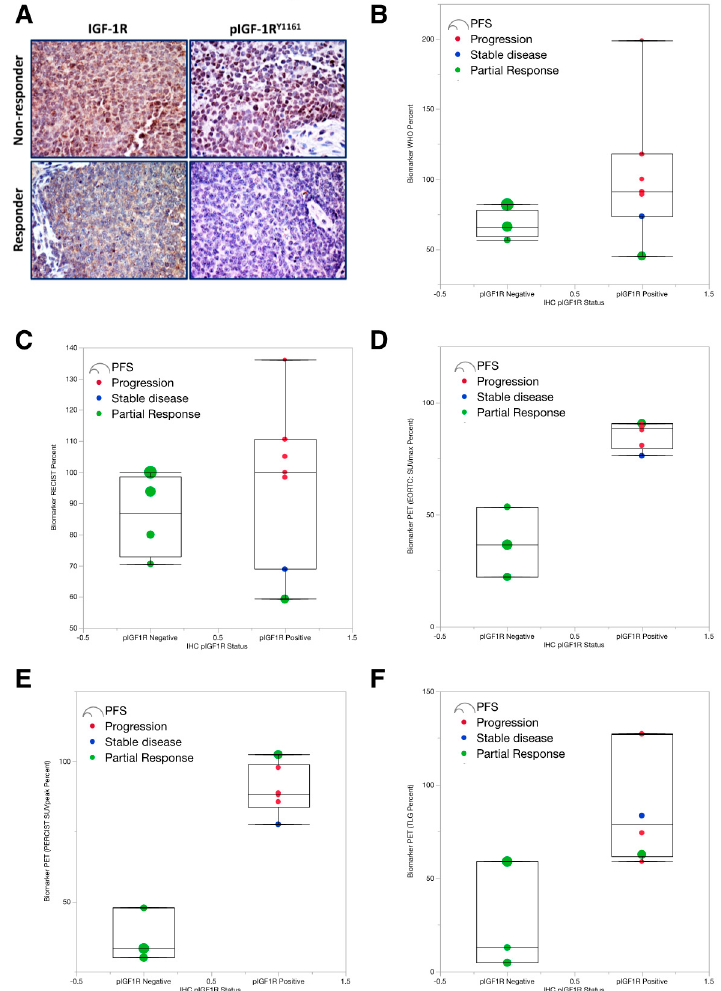
Figure 3. Negative pIGF-1R in pretreatment tumor specimens was associated with a better radiological response in the early PET/CTs performed within the first two-weeks of IGF-1R mAb-based therapy. ( A) Immunocytochemical analysis (IHC) of eighteen available pre-treatment clinical specimens for phosphorylated and total IGF-1R. Post-treatment research images (performed between days 7 and 14), as assessed by the WHO response. ES specimens from two patients are shown as representative examples. The tumors from patients 1 and 2 show high levels of expression of IGF-1R (membranous and cytoplasmic). Patient 1 had significant levels of expression of pIGF-1R (membranous and cytoplasmic, as well as scattered cells with nuclear localization). This patient had poor therapeutic response. In contrast, patient 2 had almost a total lack of expression of pIGF-1R, which was associated with a superior response to therapy. Panels B–F: Radiological response stratified by p-IGF-1R status using ( B ) the WHO response, ( C ) RECIST response, (D) EORTC measures of PET response ( E ) PERSIST measures of PET response and ( F ) total lesion glycolysis (TLG), which is a PET volumetric parameter that reflects the total metabolic activity of the entire tumor(s). Each dot reflects an individual patient. The box plots represent a quantile. Patient response is color-coded by a partial response (green), stable disease (blue), or progression (red); no patients achieved a complete response. Circle diameter indicates the PFS duration of each patient. The EORTC response measures the sum of the maximum pixel intensity (SUV max ) for each tumor, normalized to BSA, and expressed as a percent of baseline. PERCIST response relies upon the peak standard uptake value (SUV), normalized to lean body mass (LBM) within a 1-cm 3 sphere of FDG-avid tumors, expressed as standard uptake lean peak (SUL peak ); as with the EORTC criterion, SUL peak values are summed and expressed as a percentage of the baseline expression value. Values < 100% indicate tumor regression, whereas values > 100% indicate tumor growth.